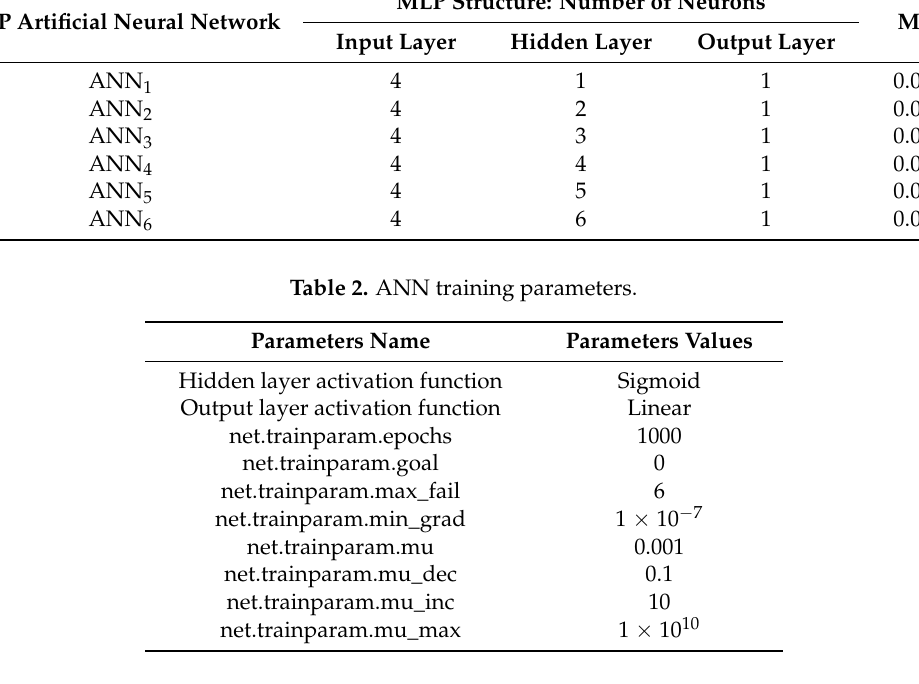
Table 3. Percent impacts on voltage harmonic distortions due to harmonic sources, HS1, HS2, HS3, and HS4, and respective impact strength classification.